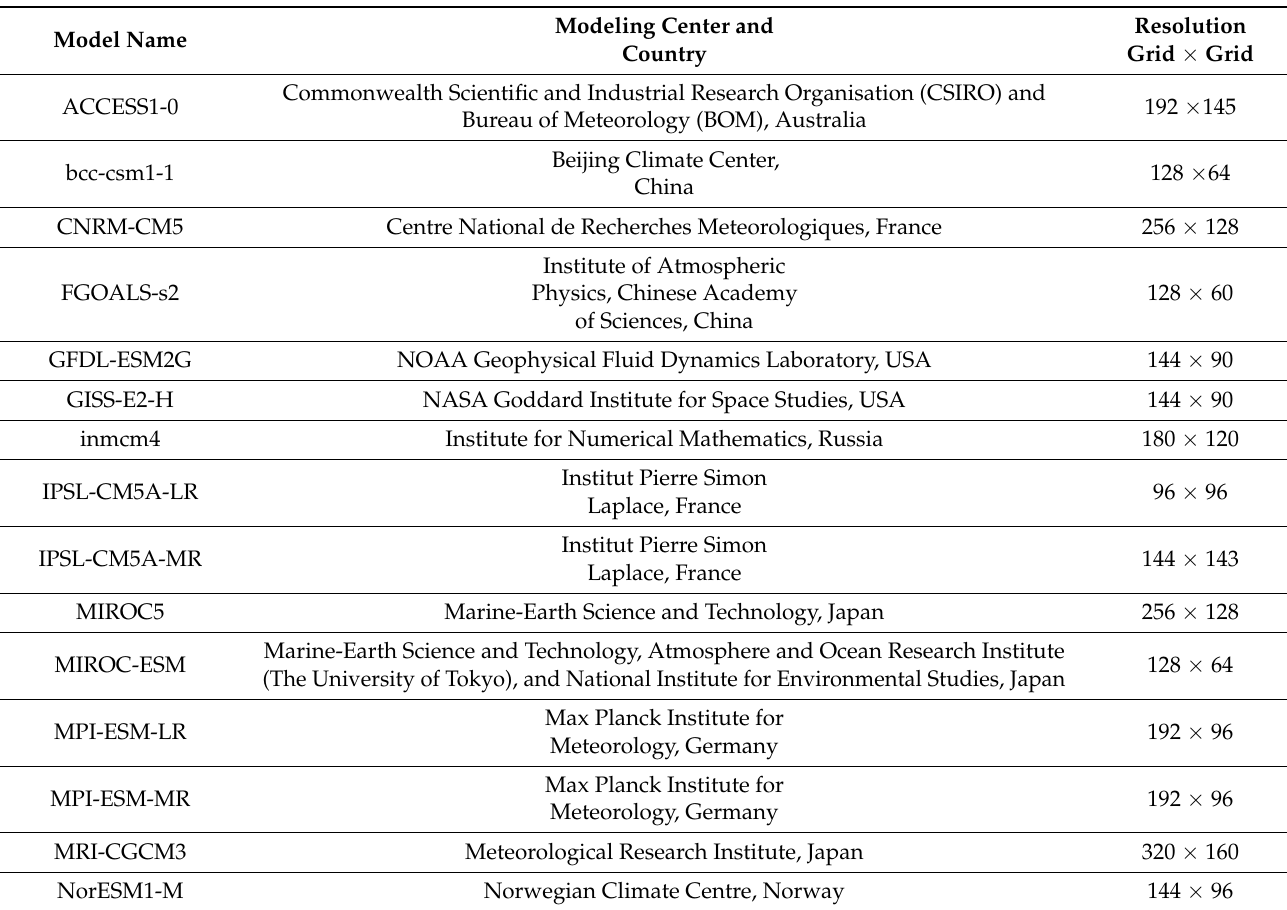
Table 1. The model identification, originating center, and